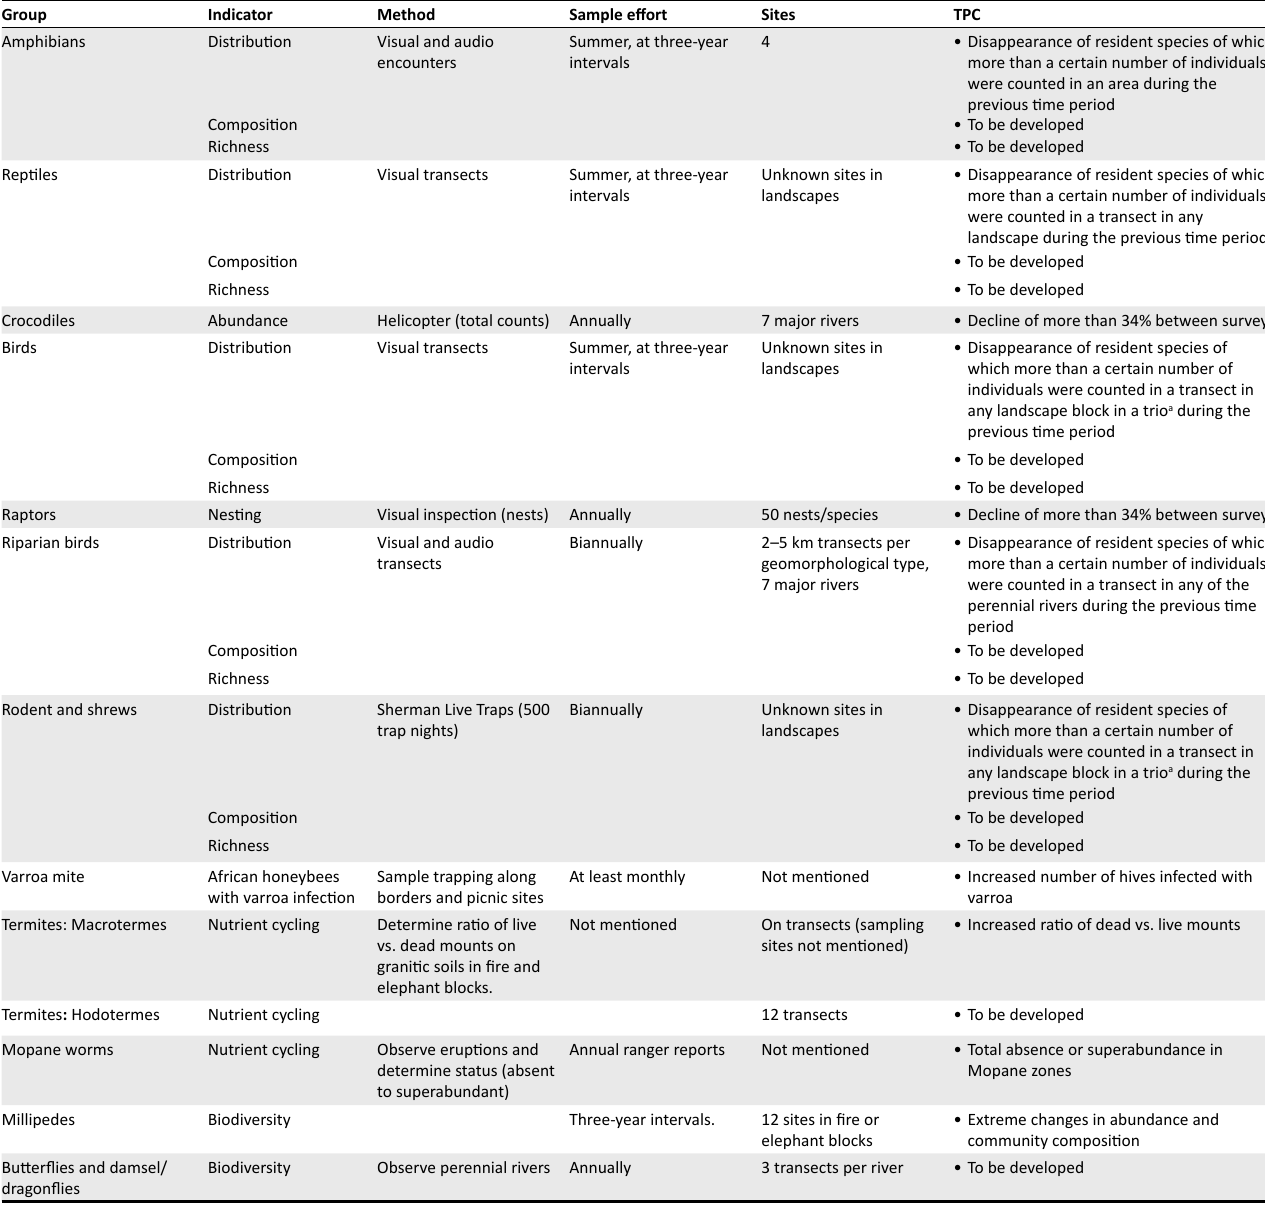
TABLE 1: Thresholds of potential concern, with a species focus, as constructed for the Kruger National Park in 2002.